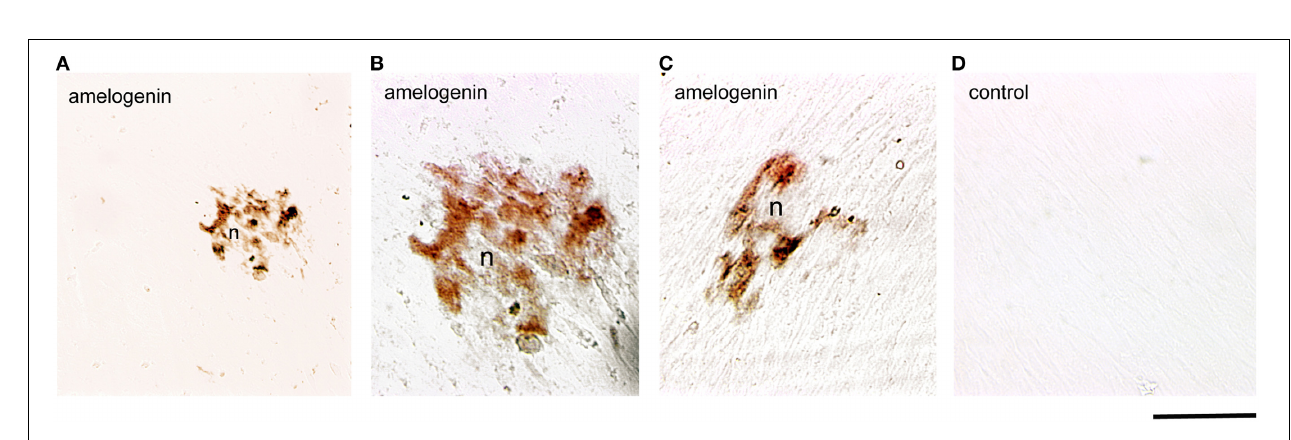
FIGURE 3 | Amelogenin immunoreactivity in human dental pulp cells cultured in vitro . (A–C) Amelogenin staining is observed in pulp cells implicated in the formation of the nodules (n) after β -glycerophosphate